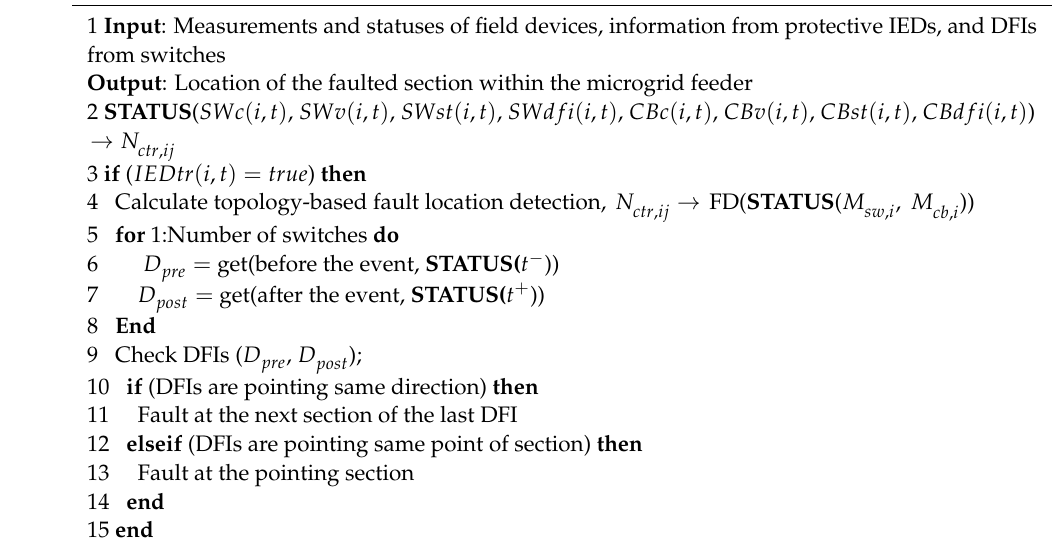
Figure 2. Single line diagram of the microgrid system.